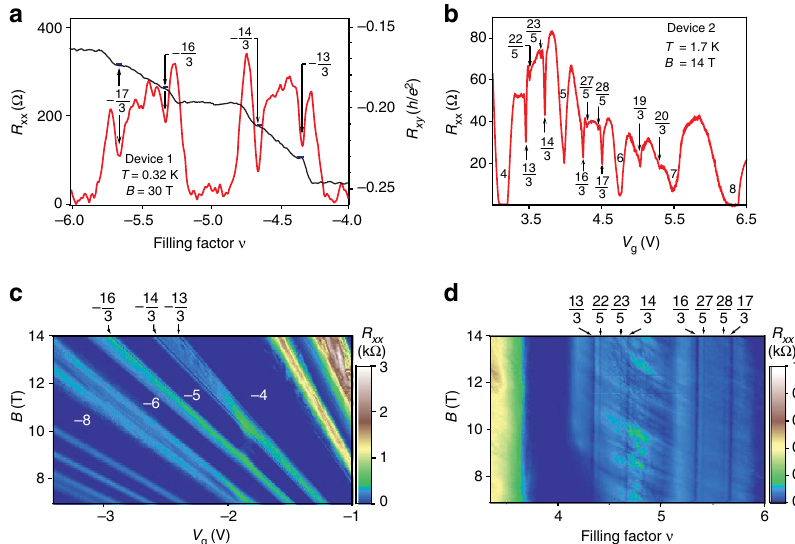
Figure 2 | Particle–hole symmetric fractional quantum Hall effect in the N ¼ 2 Landau level. ( a ) Longitudinal magnetoresistance R xx and Hall resistance R xy of device 1 at 30Tshowing pronounced fractional states. ( b ) Fractional states seen in R xx on the electron side of device 2 at 14T. ( c ) Landau fan diagram of R xx as a function of magnetic field and carrier density on the hole side for device 3. ( d ) R xx as a function of filling factor (carrier density rescaled by magnetic field) for device 2 on the electron side. Vertical features mark FQH states.